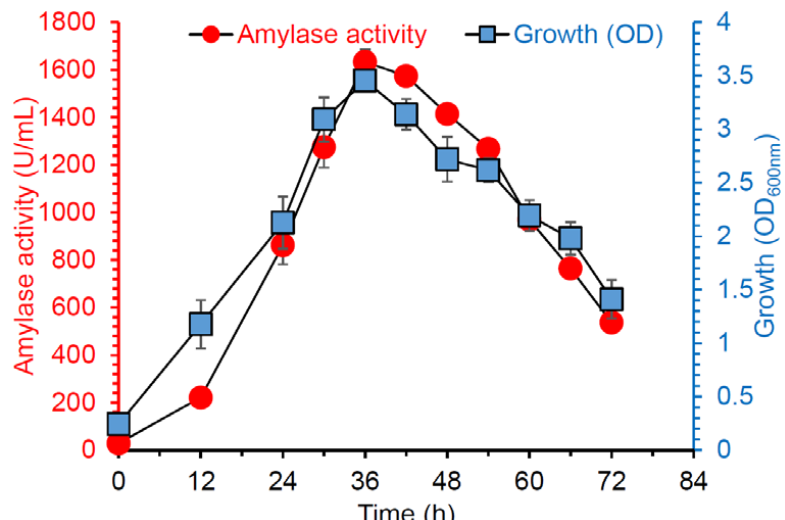
Figure 1. Batch profile of amylase production and Bacillus sp. BCC 021-50 growth in synthetic medium containing (g/L) glucose (20), yeast extract (10), MgSO 4 ⋅ 7H 2 O (1.0), NaCl (10), CaCl 2 (2.0), and KH 2 PO 4 (2.0), incubated in a shaking incubator at 37 °C with an initial pH 7.0. The experiments were performed